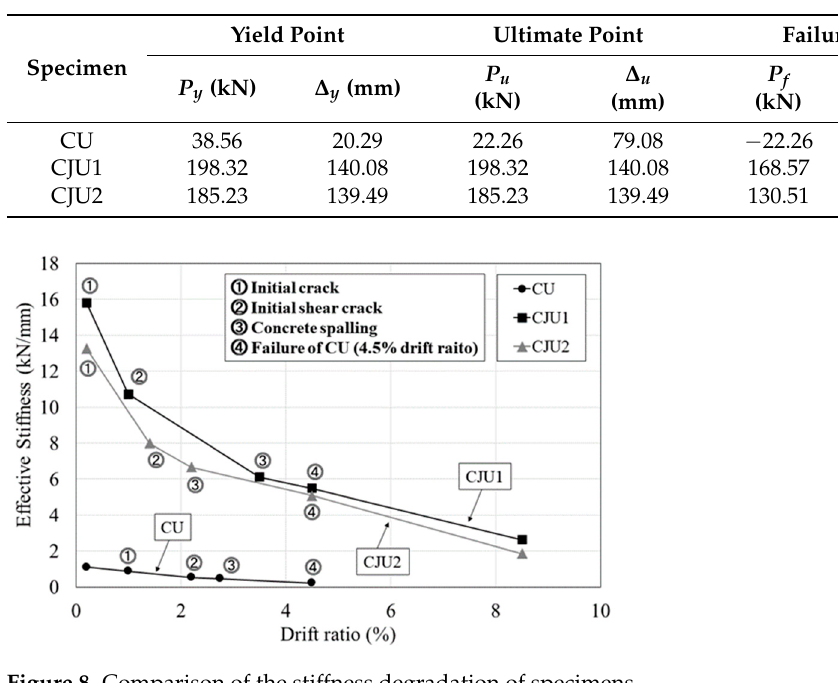
Table 6. The stiffnesses of specimens.